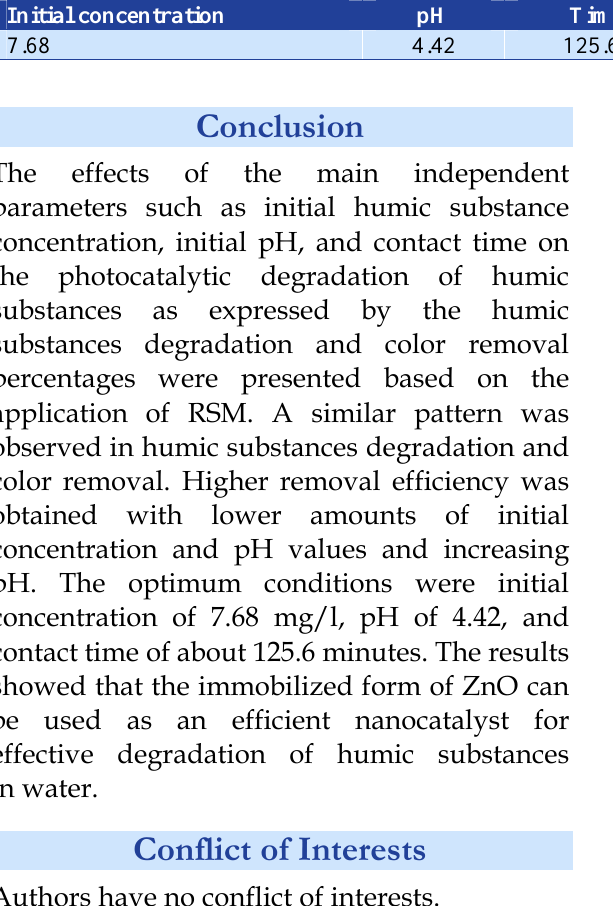
Table 5. Optimal processing conditions from numerical optimization Initial